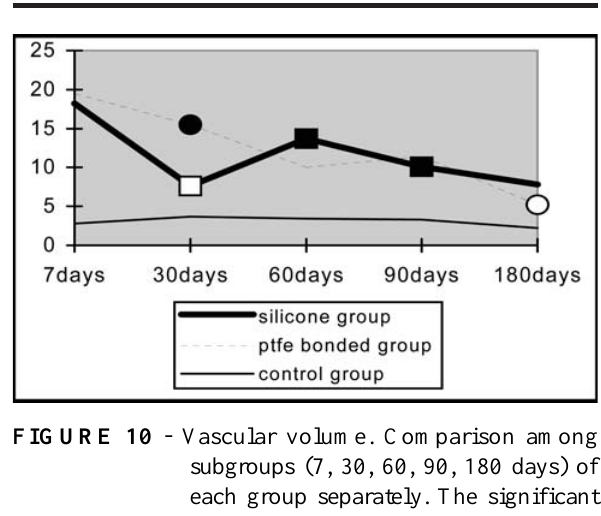
FIGURE 10 - Vascular volume. Comparison among subgroups (7, 30, 60, 90, 180 days) of each group separately. The significant value is indicated with a dark line and its comparison in a light one